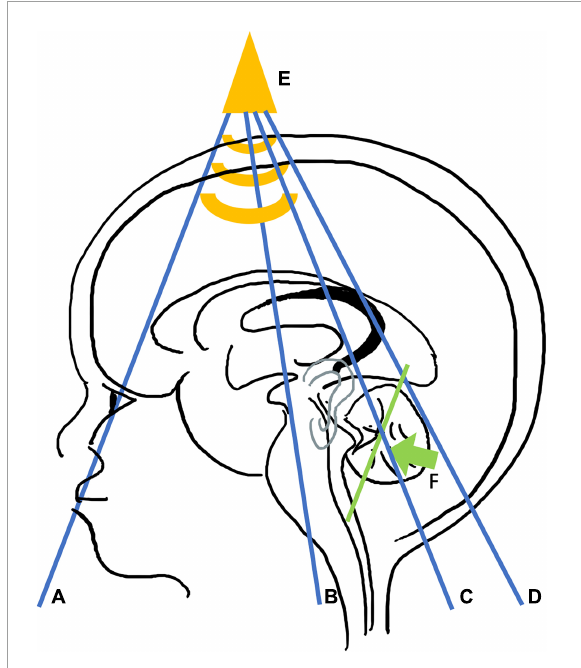
FIGURE3 Cerebral ultrasound metrics protocol. Coronal views are represented in blue: plane (A) crosses the frontal lobe, just in front of corpus callosum. Plane (B) visualizes the parietal lobes, the temporal lobes, the third ventricle, and anterior part of the brainstem. Plane (C) passes through the lateral ventricles and the cerebellum at the location of its maximum width, just behind the fourth ventricle. Plane (D) shows the posterior horn of the lateral ventricles and choroid plexus. Bi frontal diameter is measured through plane (A) ( Figure 1B ); bone and brain parietal diameters, subarachnoidian, and inter-hemispheric spaces through plane (B) ( Figure 1D ), transcerebellar diameter through plane (C) ( Figure 2B ), and the lateral ventricle diameters through plane (D) ( Figure 1F ). Sagittal view (E) is displayed in yellow. The corpus callosum length and width, and the vermis anteroposterior diameter and length are assessed per this view ( Figure 2E ). The posterior mastoid view (F) is illustrated in green. The transducer is placed perpendicular to the mastoid behind